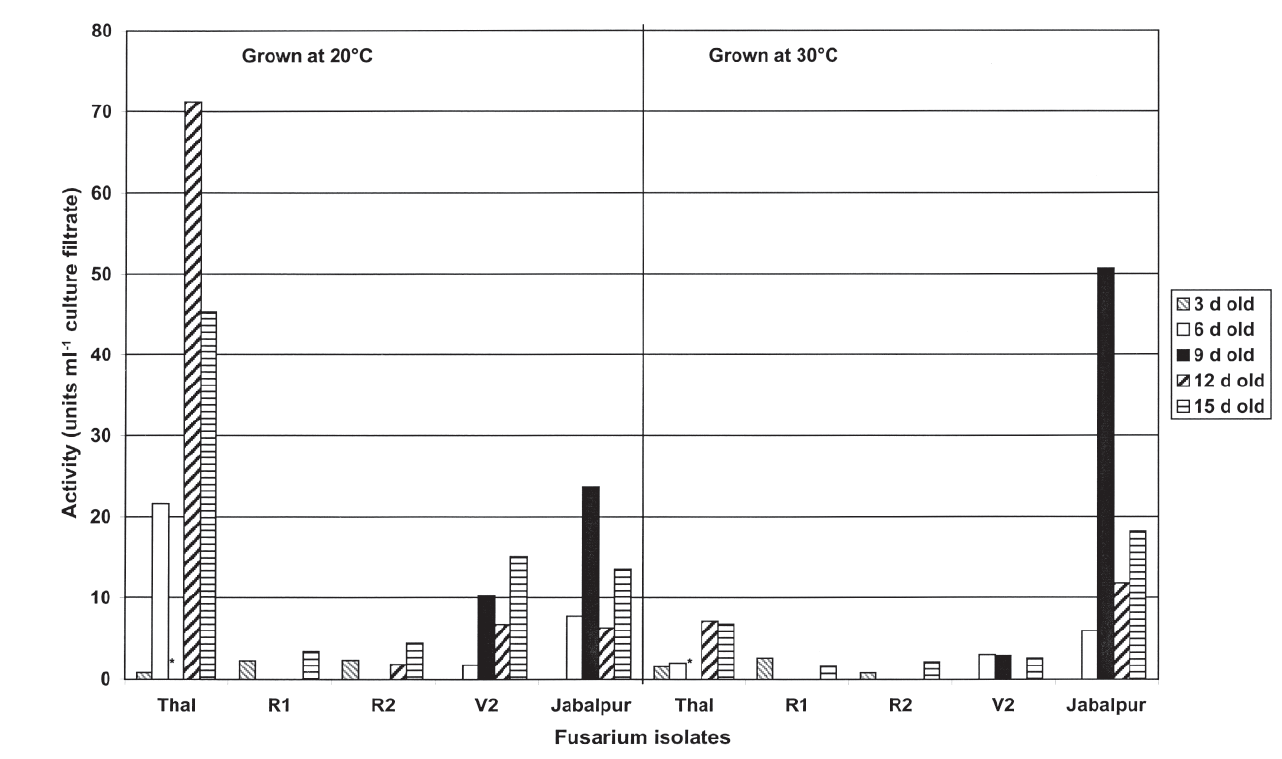
Fig. 1. Time course of toxin production by five isolates of Fusarium from chickpea at two temperatures. Chickpea cells, isolated from the plant, were employed in an assay of the toxicity of culture filtrates and the results expressed as units of activity where 1 unit of activity was the amount of toxin required to kill 50% of the cells (for details see text). * No